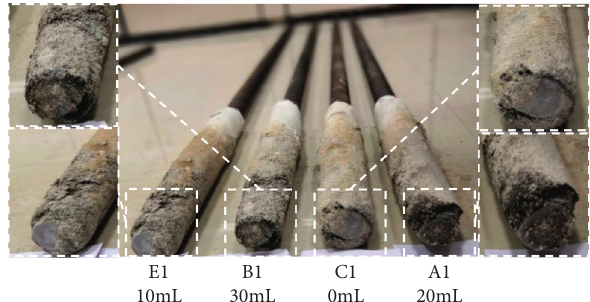
Figure 5: Specimens after the pull-out test (part).